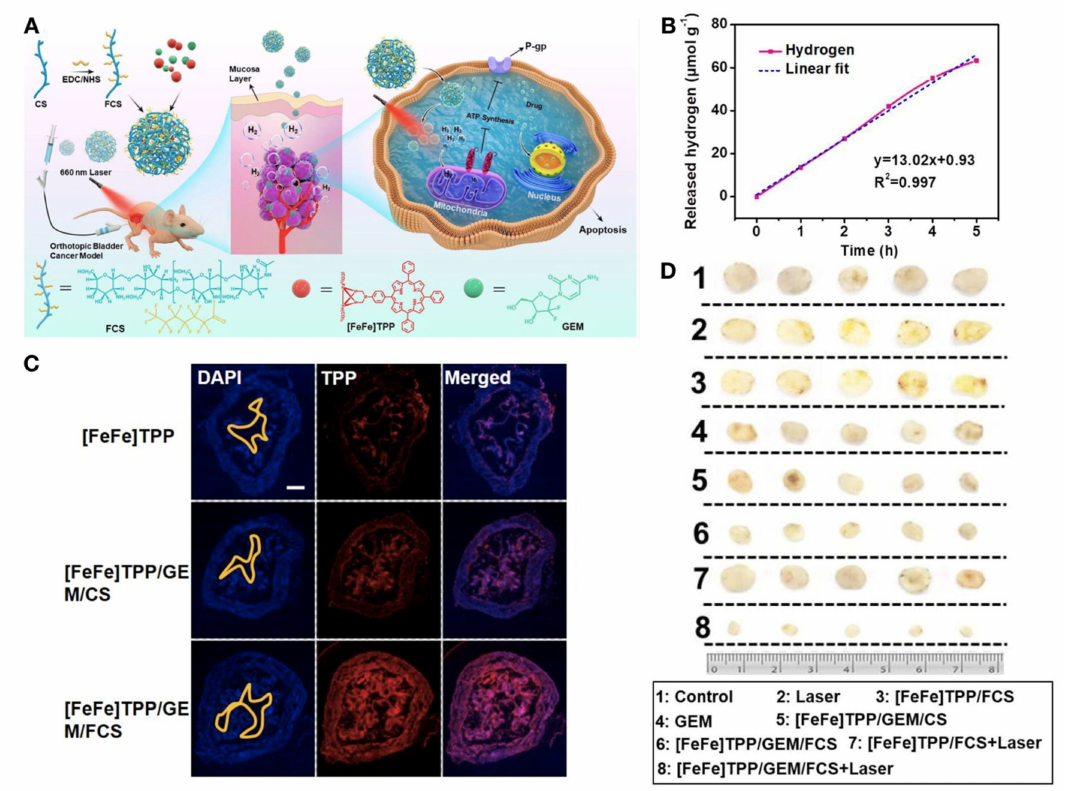
Figure 5. ( A ) A photoactivated H 2 nanogenerator that comprises an FCS, gemcitabine, and a